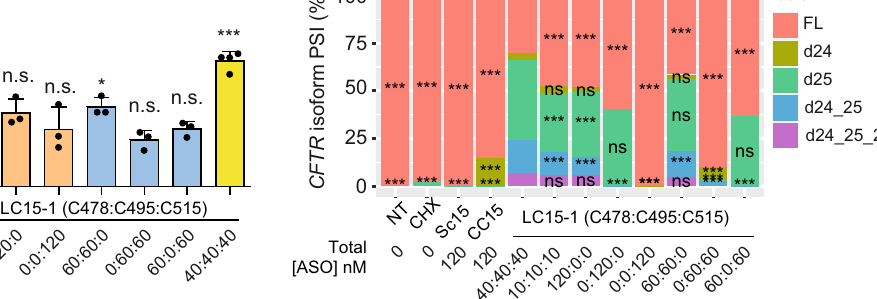
did not cause any exon 26 skipping overlapped with an SRSF5/ cient to predict an ASO ’ s interference with splicing. Transfection of LC15-1 or LC18 caused dose-dependent, multiple exon skipping in human bronchial cells (Fig. 2i, Supplementary Fig. 8a – f): single (exon 24 or 25 skipping: